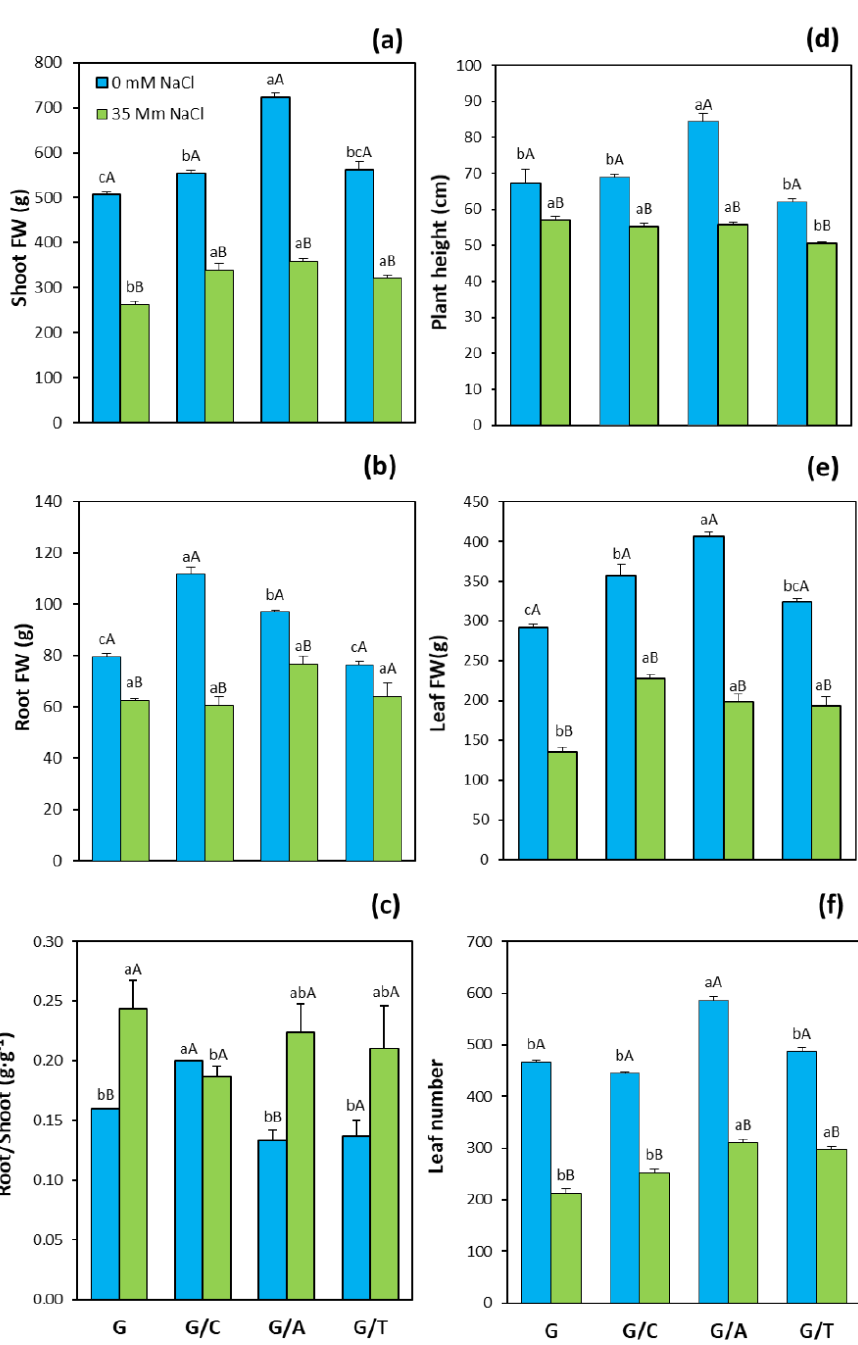
Figure 1. ( a ) Shoot fresh weight (FW), ( b ) root FW, ( c ) root-to-shoot ratio, ( d ) plant height, ( e ) leaf FW, and ( f ) leaf number of pepper plants of the commercial variety “Gacela F1” either non-grafted (G) or grafted onto commercial rootstocks Creonte (G/C), Atlante (G/A), and Terrano (T/A), and cultivated under control (0 mM NaCl) and salinity (35 mM NaCl) conditions. Bars show the means of five plants ± standard error. Different capital letters indicate significant differences due to the salt treatment while different small letters show significant differences among graft combinations according to Tukey’s test ( p ≤